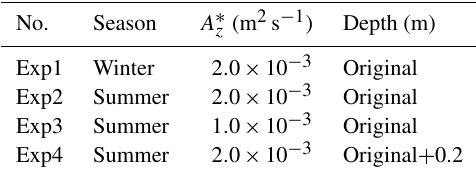
Table 3. Model settings for the numerical